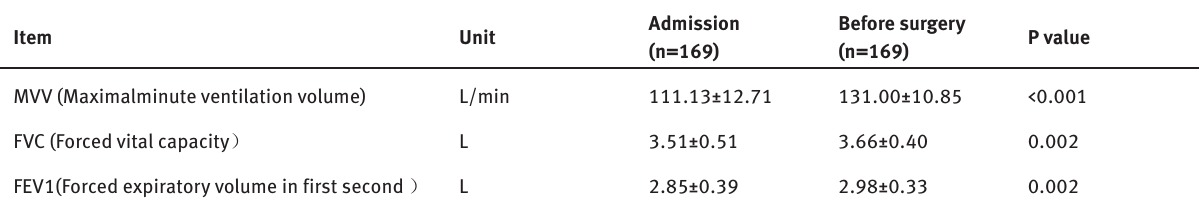
Table 6: Comparison of pulmonary function indices of the enhanced recovery group in admission and before the surgery.